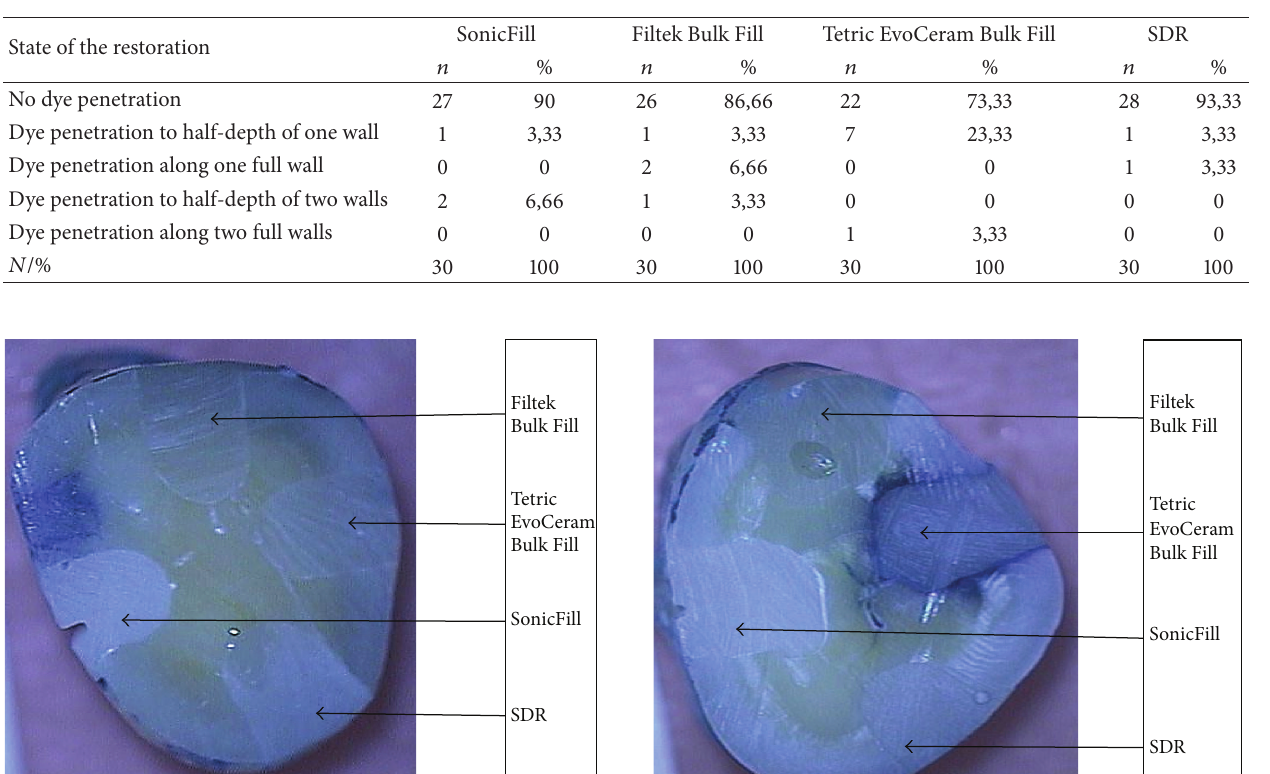
Table 2: Dye leakage around examined restorations.